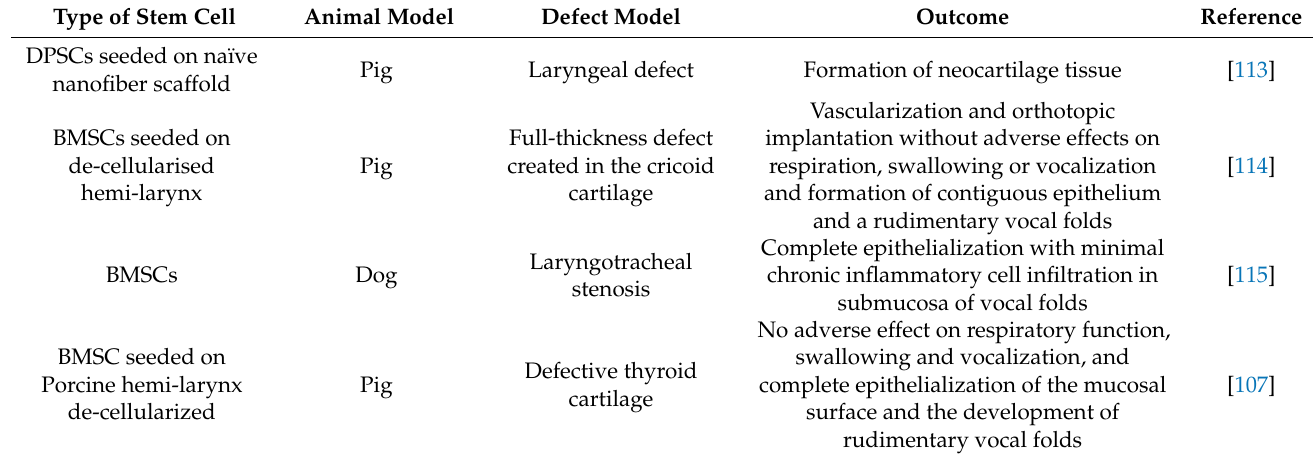
Table 3. In vivo studies of laryngeal defects and